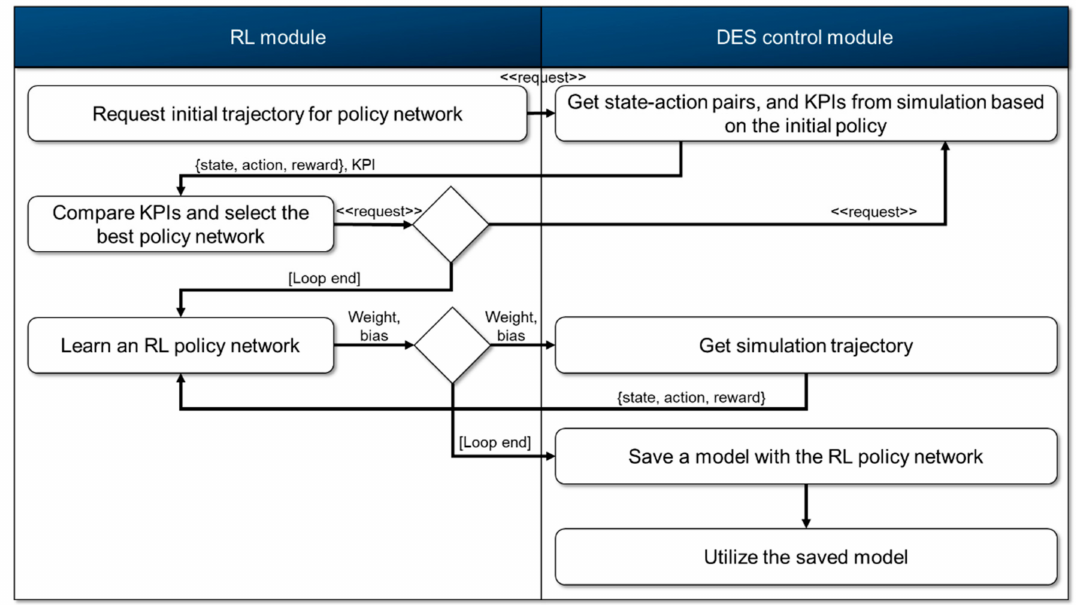
Figure 8. Module-integration procedure of proposed scheduling